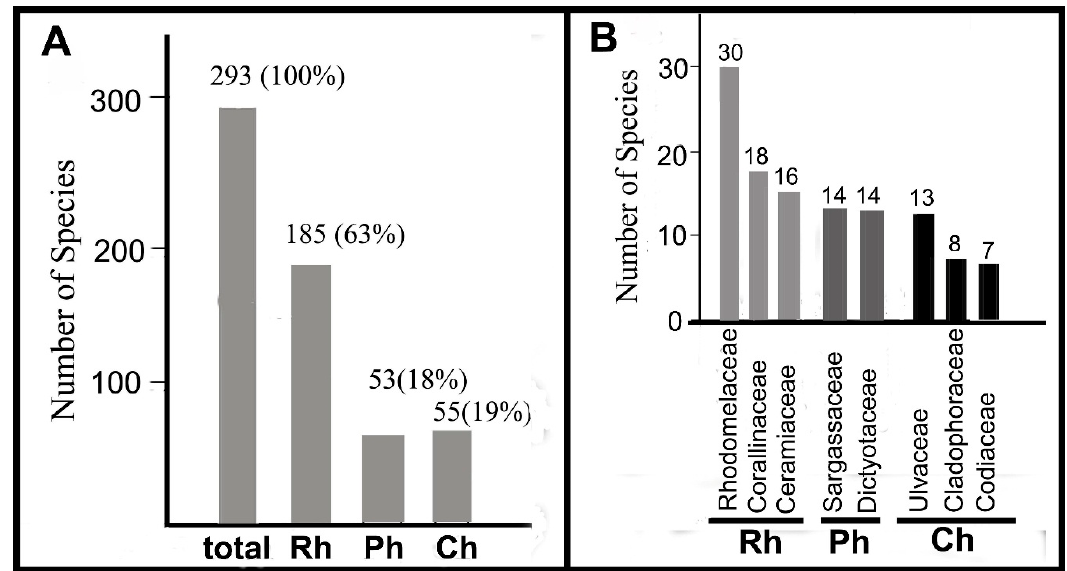
Figure 2. Species diversity and composition of seaweeds ′ assemblages along coast of the Tomioka Peninsula in 2012 − 2017. ( A ) Absolute and relative species numbers of different taxonomic groups Rhodophyta, Phaeophyceae, Chlorophyta (Rh, Ph, Ch). ( B ) Species numbers in dominant families.